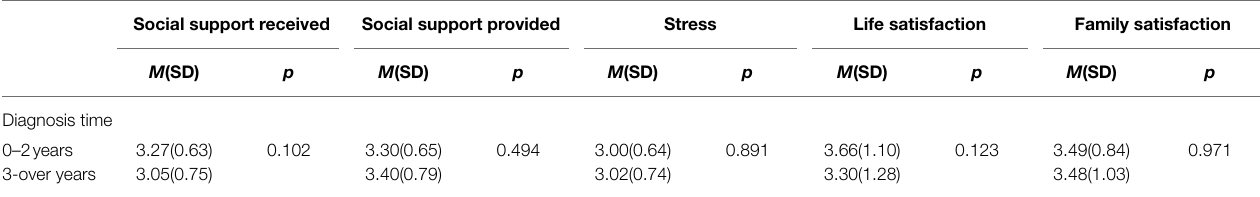
TABLE 5 | Mean differences in social support, stress, life satisfaction and family satisfaction according to the diagnosis time.